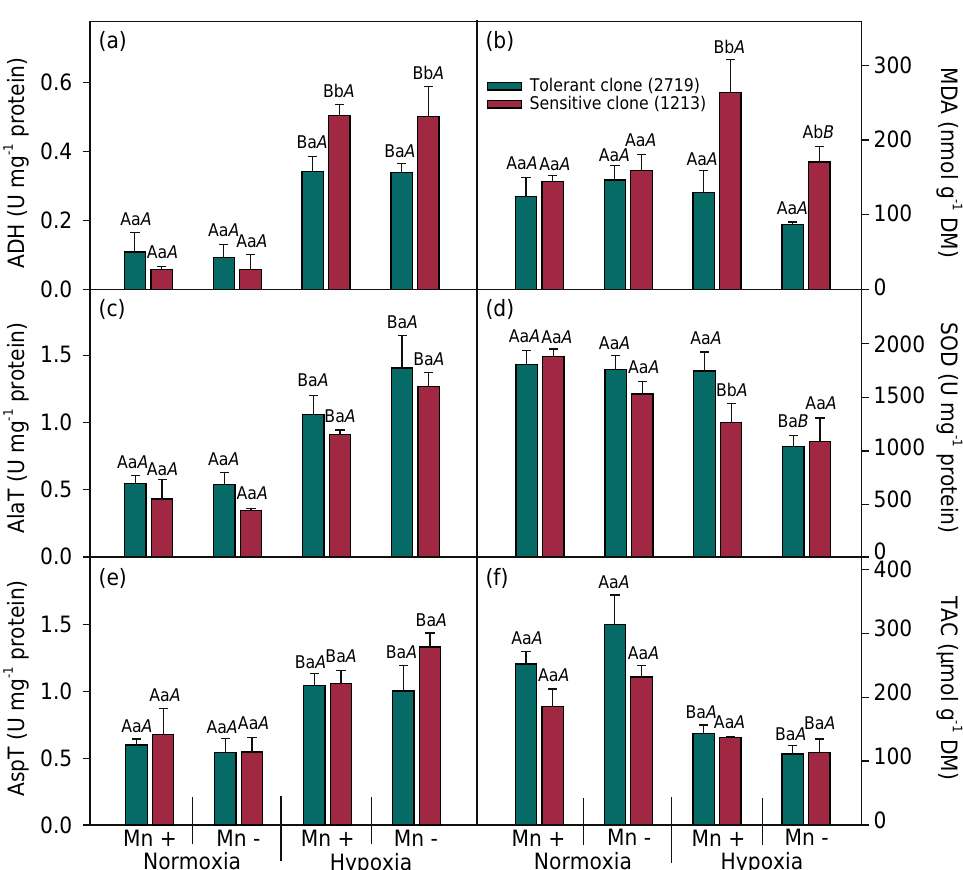
Figure 5. Enzymatic activity and metabolites in roots from two Eucalyptus clones in hydroponics in response to the treatments. Alcohol dehydrogenase activity (a). Level of malondialdehyde (b). Alanine transaminase activity (c). Superoxide dismutase activity (d). Aspartate transaminase activity (e). Total antioxidant capacity (f). Uppercase letters compare the effect of O 2 (normoxia: 8 mg L -1 and hypoxia: 4 mg L -1 ) for the same clone and the same Mn concentration. Lowercase letters compare the effect of clones (tolerant and sensitive to VRDSD) for the same concentrations of Mn and O 2 . Uppercase italic letters compare the effect of the Mn concentration of the nutrient solution (300 and 1.39 mg L -1 ) for the same clone and the same O 2 concentration. Equal letters do not differ statistically at the level of 5